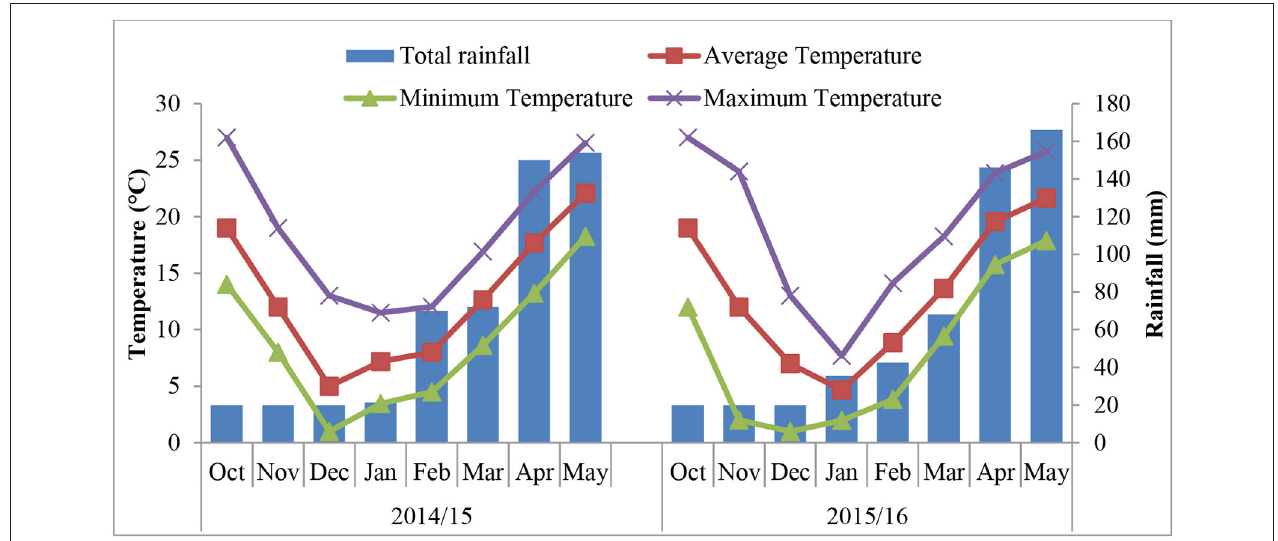
FIGURE 1 | Monthly total rainfall and monthly maximum, minimum and mean temperature during the growing seasons of the two experiments.